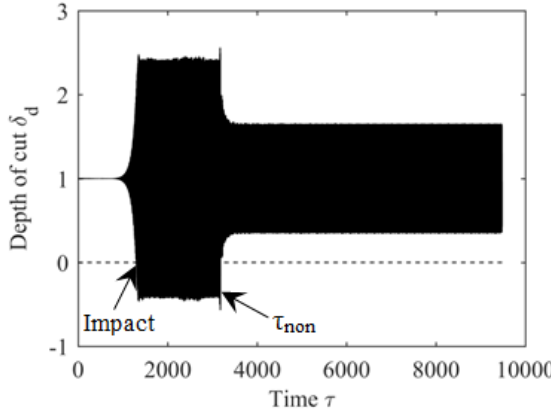
Fig. 11. Time histories with the nonlinear velocity